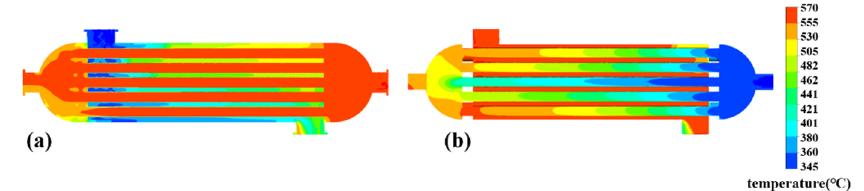
Figure 6. The temperature distribution cloud diagram when the heat transfer working medium in the superheater is located at different positions. ( a ) Water vapor is on the shell side. ( b ) Water vapor is on the tube side.